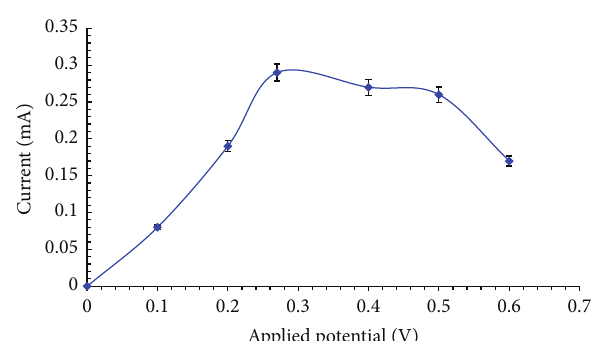
Figure 8: Effect of incubation temperature on the response of present method.